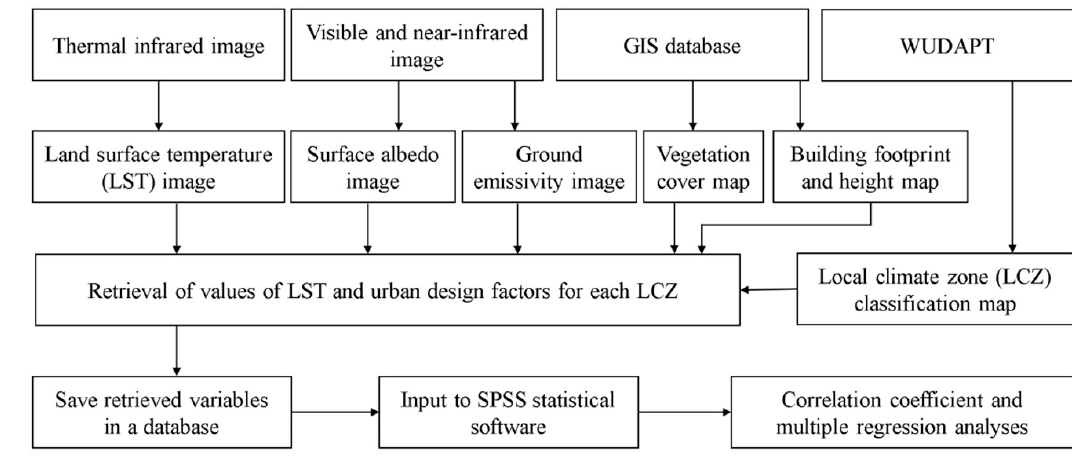
Figure 2. The framework of this study.